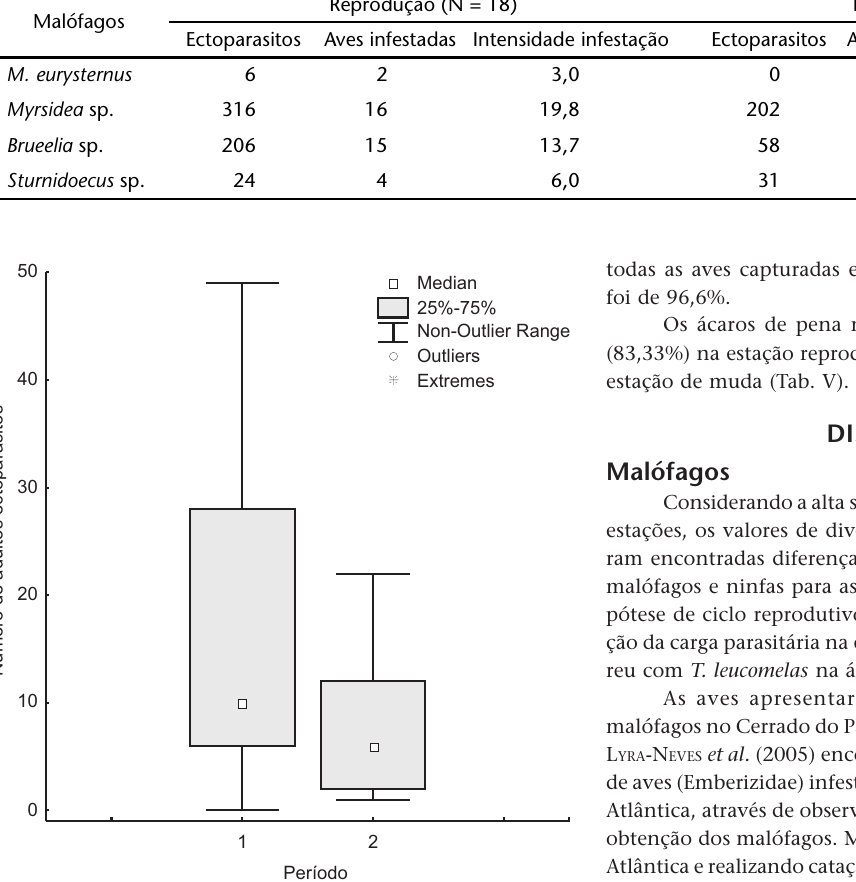
Tabela IV. Intensidade média de infestação dos malófagos encontrados em T . leucomelas nas estações reprodutiva e de troca de penas (outubro e dezembro 2006/março 2007) no Parque Estadual do Rio Preto. (N) Número de indivíduos coletados.